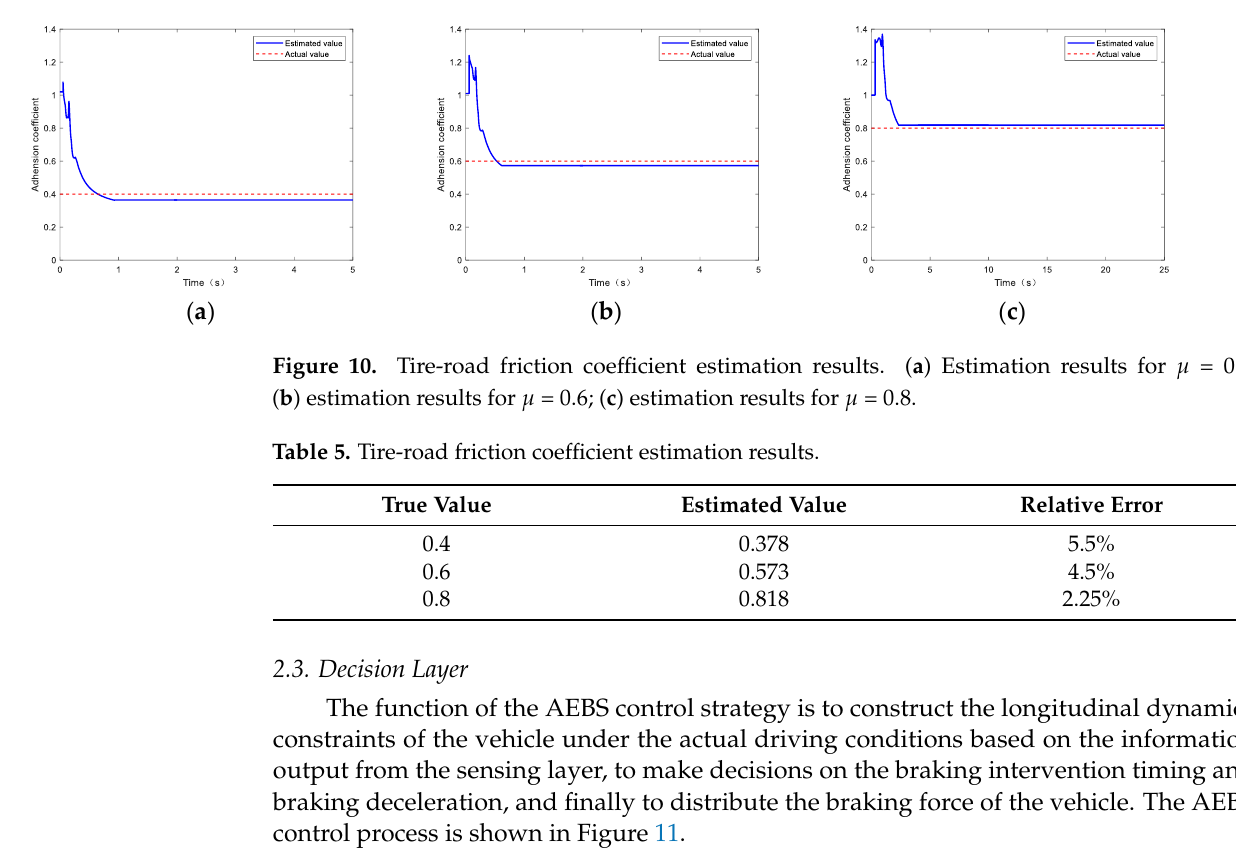
Figure 11. AEBS decision layer control strategy architecture.